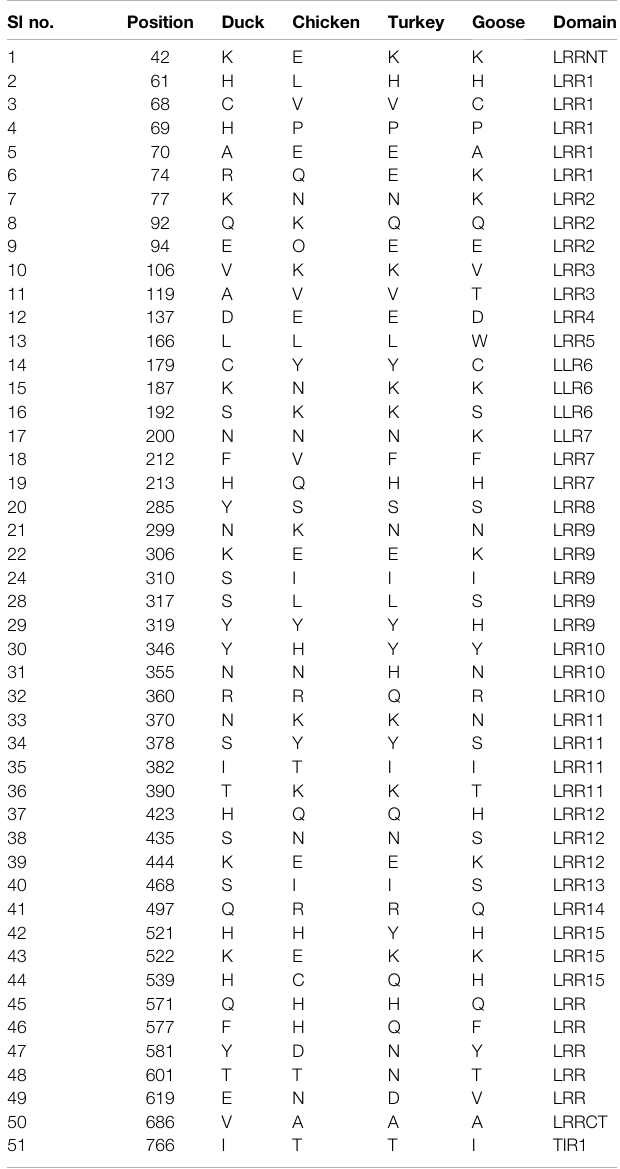
TABLE 2| AminoacidvariationsforTLR3geneinduckwithotherpoultryspecies. Sl